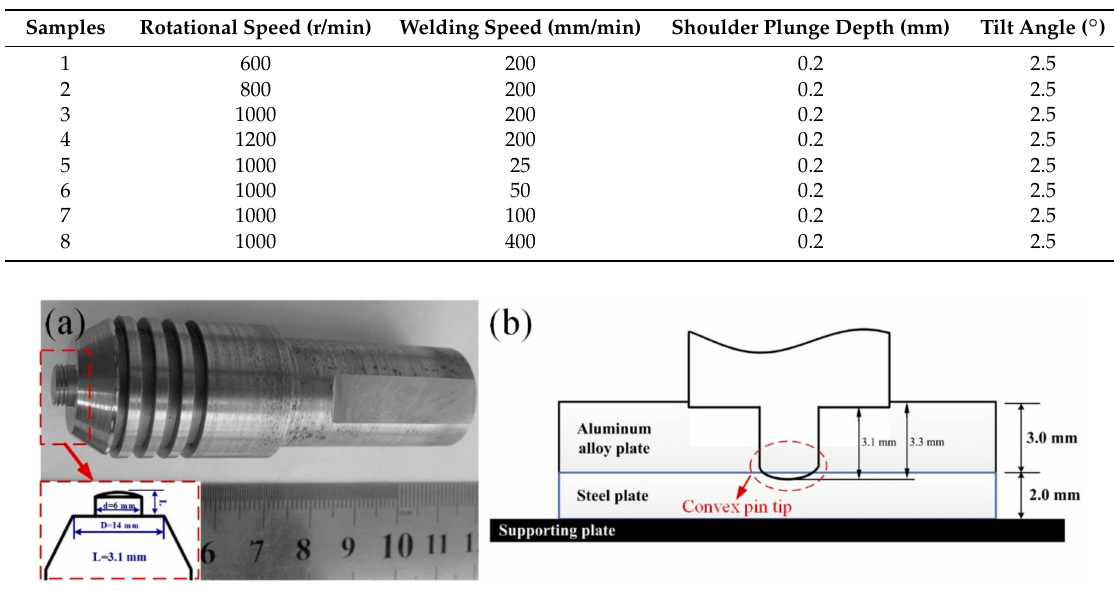
Table 2. The combination of the process parameters.